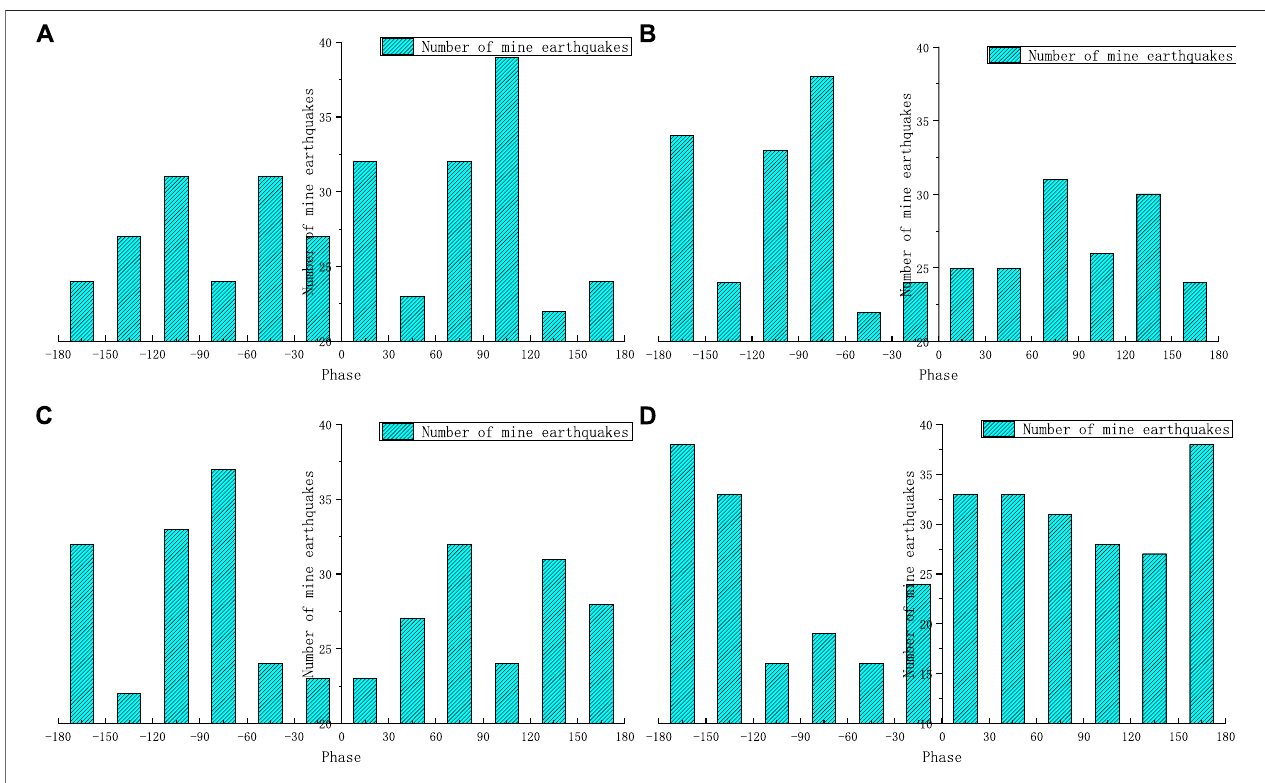
FIGURE 7 | Statistical histogram of the mine earthquake 1.0 ≤ M L < 1.5 frequency.